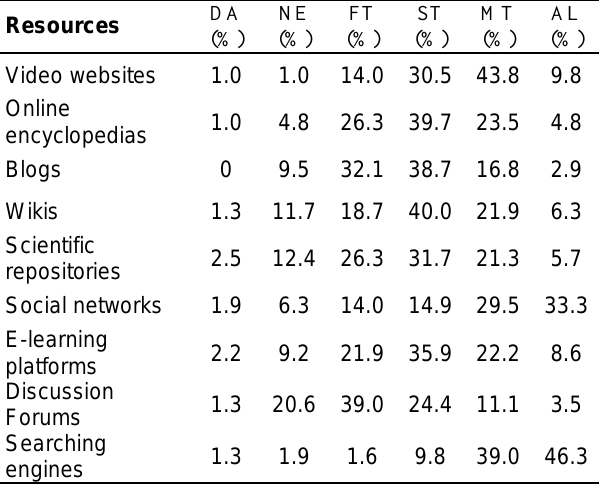
Table 4. Use frequency of the resources in the support to learning (n=315) Table 5. Means of use frequency of the resources in the support to learning (range 0 to 5